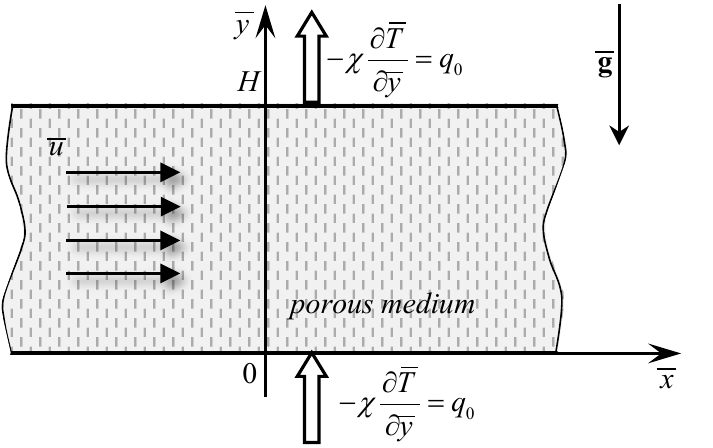
Figure 1. Sketch of the porous layer heated from below and cooled from above by equal constant heat fluxes with horizontal